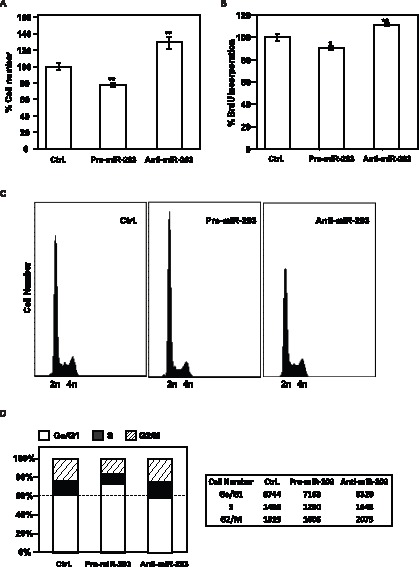
Influence of miR-203 on cell proliferation.A, 48 h after transfection of HeLa cells with the miRNAs shown, cell numbers were measured using a hemocytometer and represented as percentage of cells relative to the scrambled Ctrl miRNA group. B, measurement of BrdU incorporation by 48 h after transfection of HeLa cells with the indicated miRNAs. The data in panels A, and B are the means ± SEM from three experiments. Significant differences in cell number (A) and BrdU incorporation (B) in the indicated transfected miRNA compared to transfected scrambled (Ctrl) miRNA are indicated (*p<0.05, **p<0.01). C, forty-eight h after transfection with scrambled Ctrl miRNA, Anti-miR-203, or Pre-miR-203, HeLa cells were subjected to FACS analysis. D, the relative G1, S, and G2/M compartments shown in C were calculated and represented in left panel, and total cell numbers in every stage cell cycle compartment were included in the right panel. Data (C and D) are representative of three independent experiments.